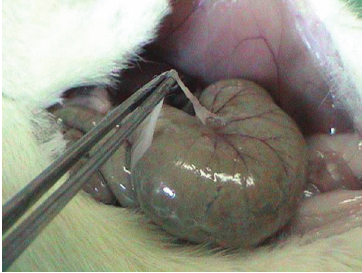
Figure 2 - The appearance of Grade 1 adhesion in Group 2 (Seprafilm group), which developed on the uncovered area on the